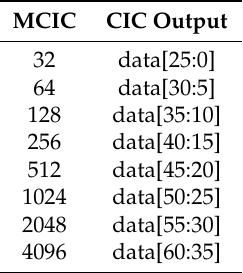
Figure 10. Structure of the cascaded integrator comb (CIC) filter. Table 2. Data truncation at different